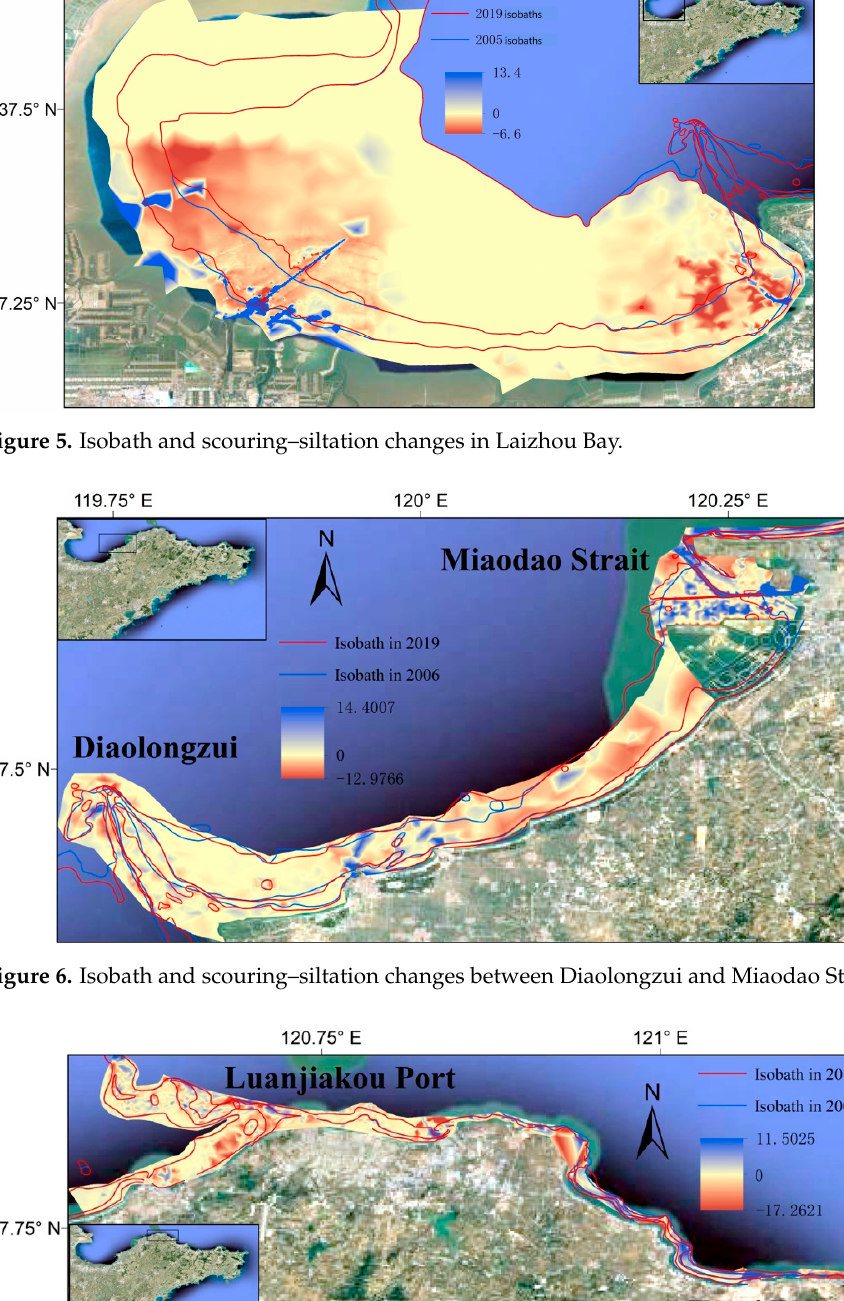
Figure 8. Elevation change in cross-section (P01 to P04).